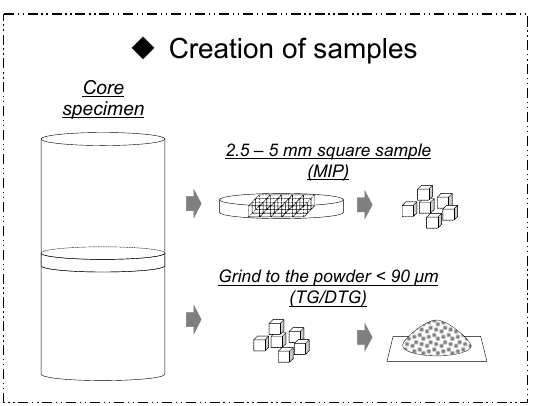
Figure 3. Sampling of specimen for evaluation of MIP&TG-DTA.